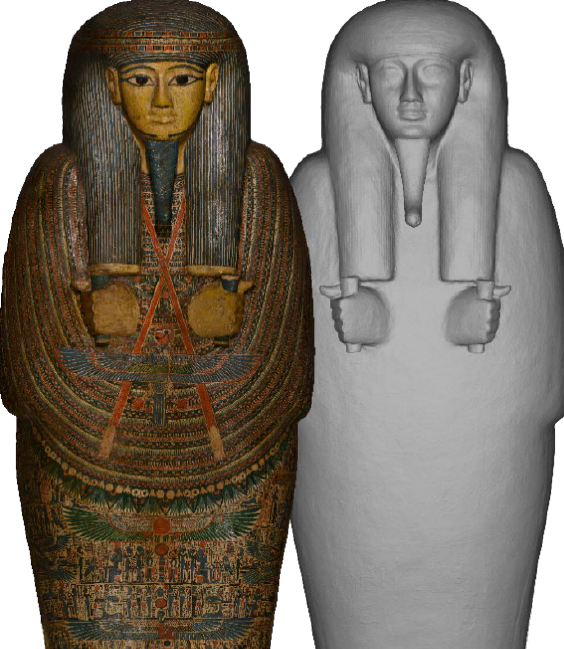
Figure 1. From left to right: orthophoto with and without colour. Inner (©Rijksmuseum van Oudheden,